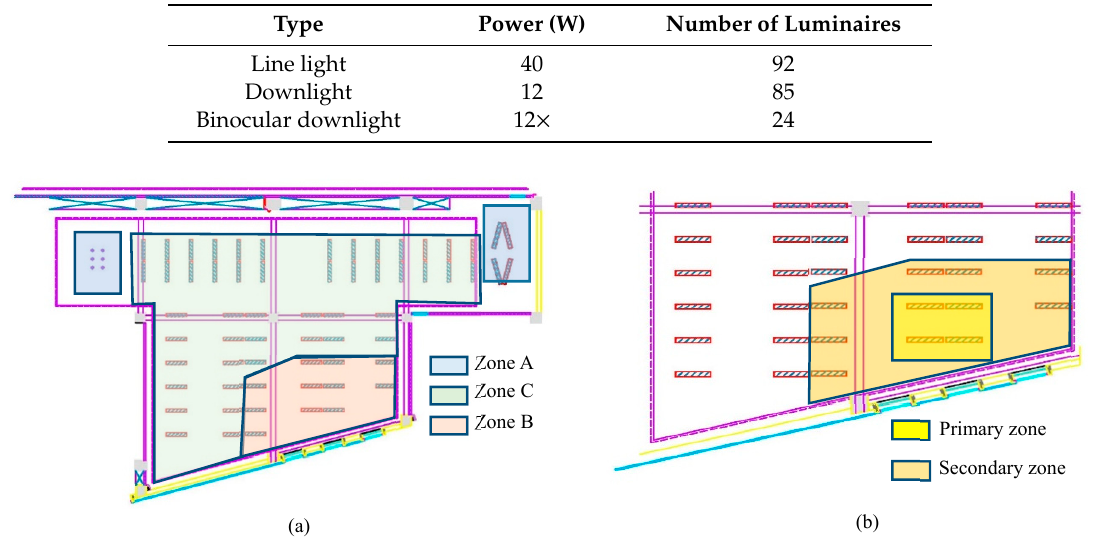
Figure 14. Division of the largest office room for smart light control: ( a ) Zones A, B, and C in the control strategy and ( b ) PZ and SZ for daylight harvesting.